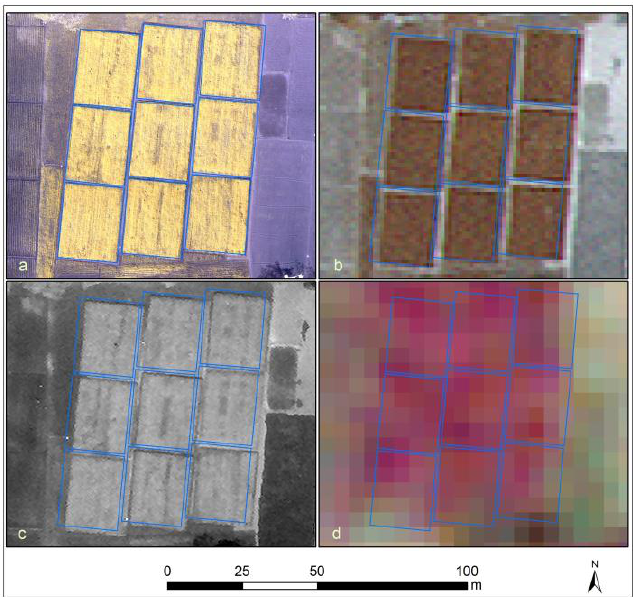
Figure 1. Example of smallholder fields in Barisal, Bangladesh, as depicted by different remote sensors: ( a ) Unmanned Aerial Vehicle (UAV) (Tetracam five-band mini-MCA (multi-camera array) false-colour composite), ( b ) WorldView-2/3 multispectral false-colour composite, ( c ) WorldView-2/3 panchromatic, and ( d ) RapidEye false-colour composite. The overlay parallelograms indicate nine adjacent farm fields. The apparent misalignment between the satellite images at ( b – d ) and the polygons are a result of the relatively low horizontal positional accuracy with which the satellite images were delivered.